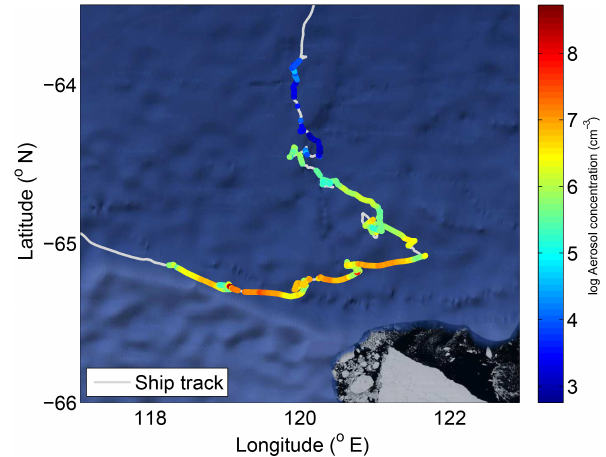
Figure A3. CN 3 − 10 number concentrations in log scale, overlayed on the ship’s track (grey line) and Google Earth satellite imagery. The step change is observed clearly around 64.4 ◦ S, while a gradual increase can be discerned with increasing latitude within the polar